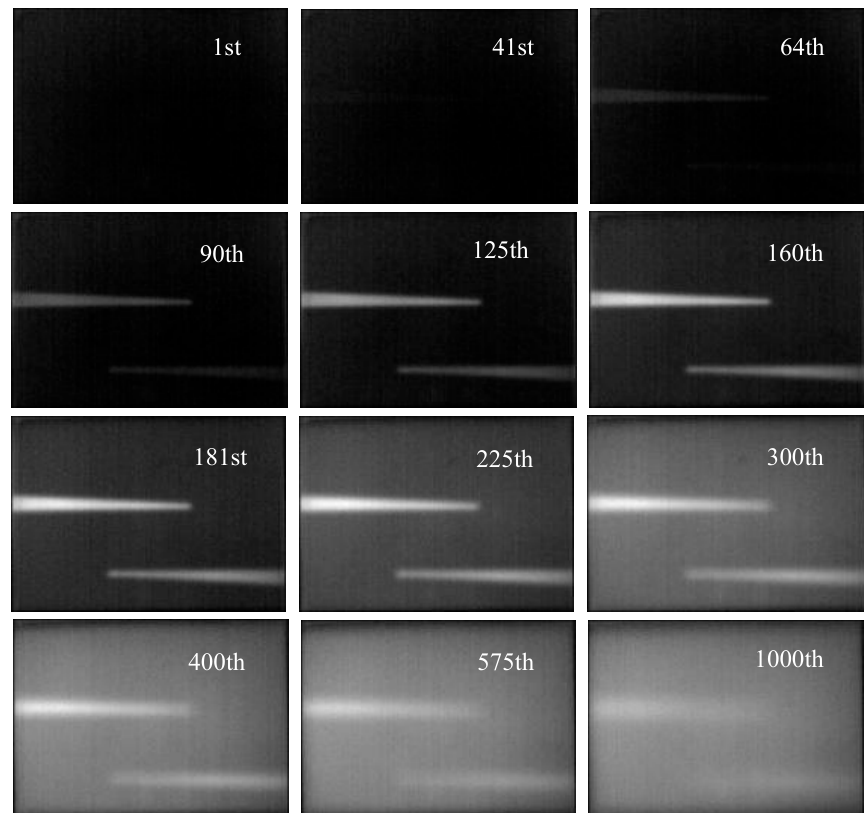
Figure 8. Distribution of temperature field on the surface of the PVC test object in the sequence.